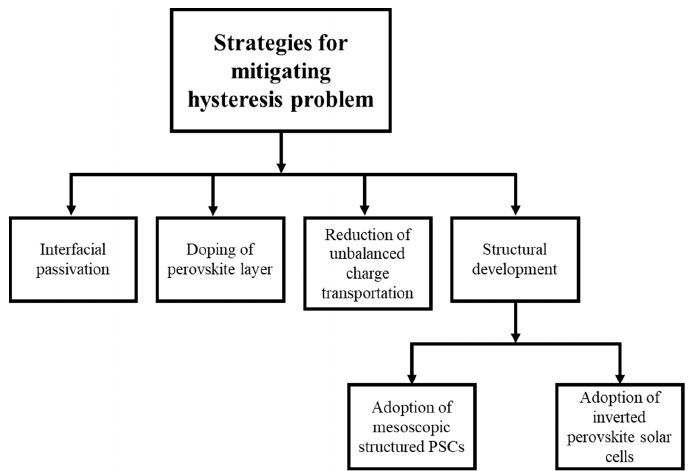
Figure 7. A summary of the strategies for mitigating or reducing hysteresis in